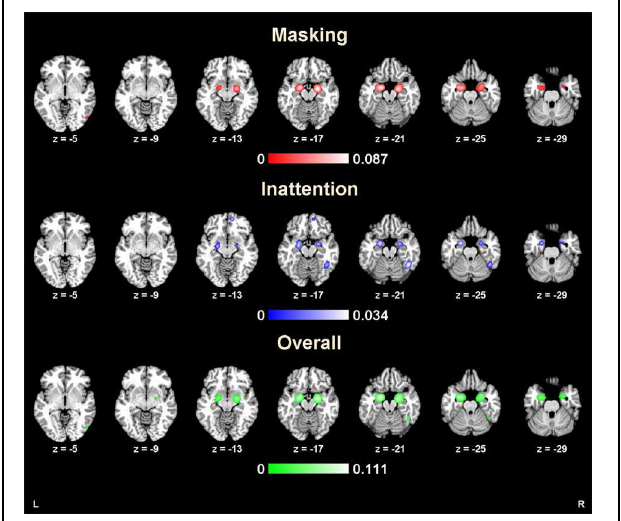
FIGURE 1 | Results from ALE analysis for masking tasks, inattention tasks, and overall studies ( p < 0 . 01; FDR corrected; k > 100).